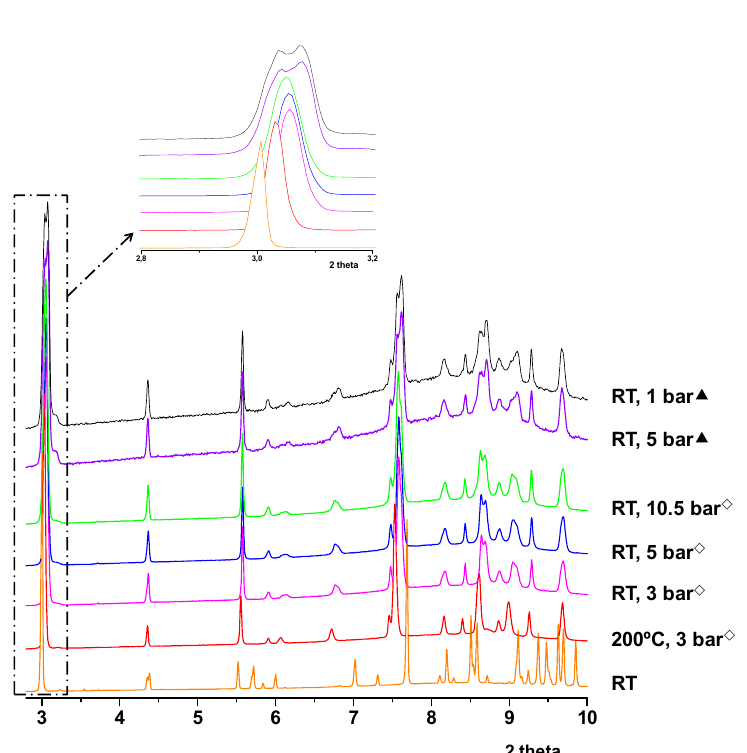
Figure 6. Synchrotron X-ray powder diffraction patterns for Compound 1 at different CO 2 pressures. Inset: splitting of diffraction peaks upon CO 2 adsorption ( )/desorption ( ). (cid:51)